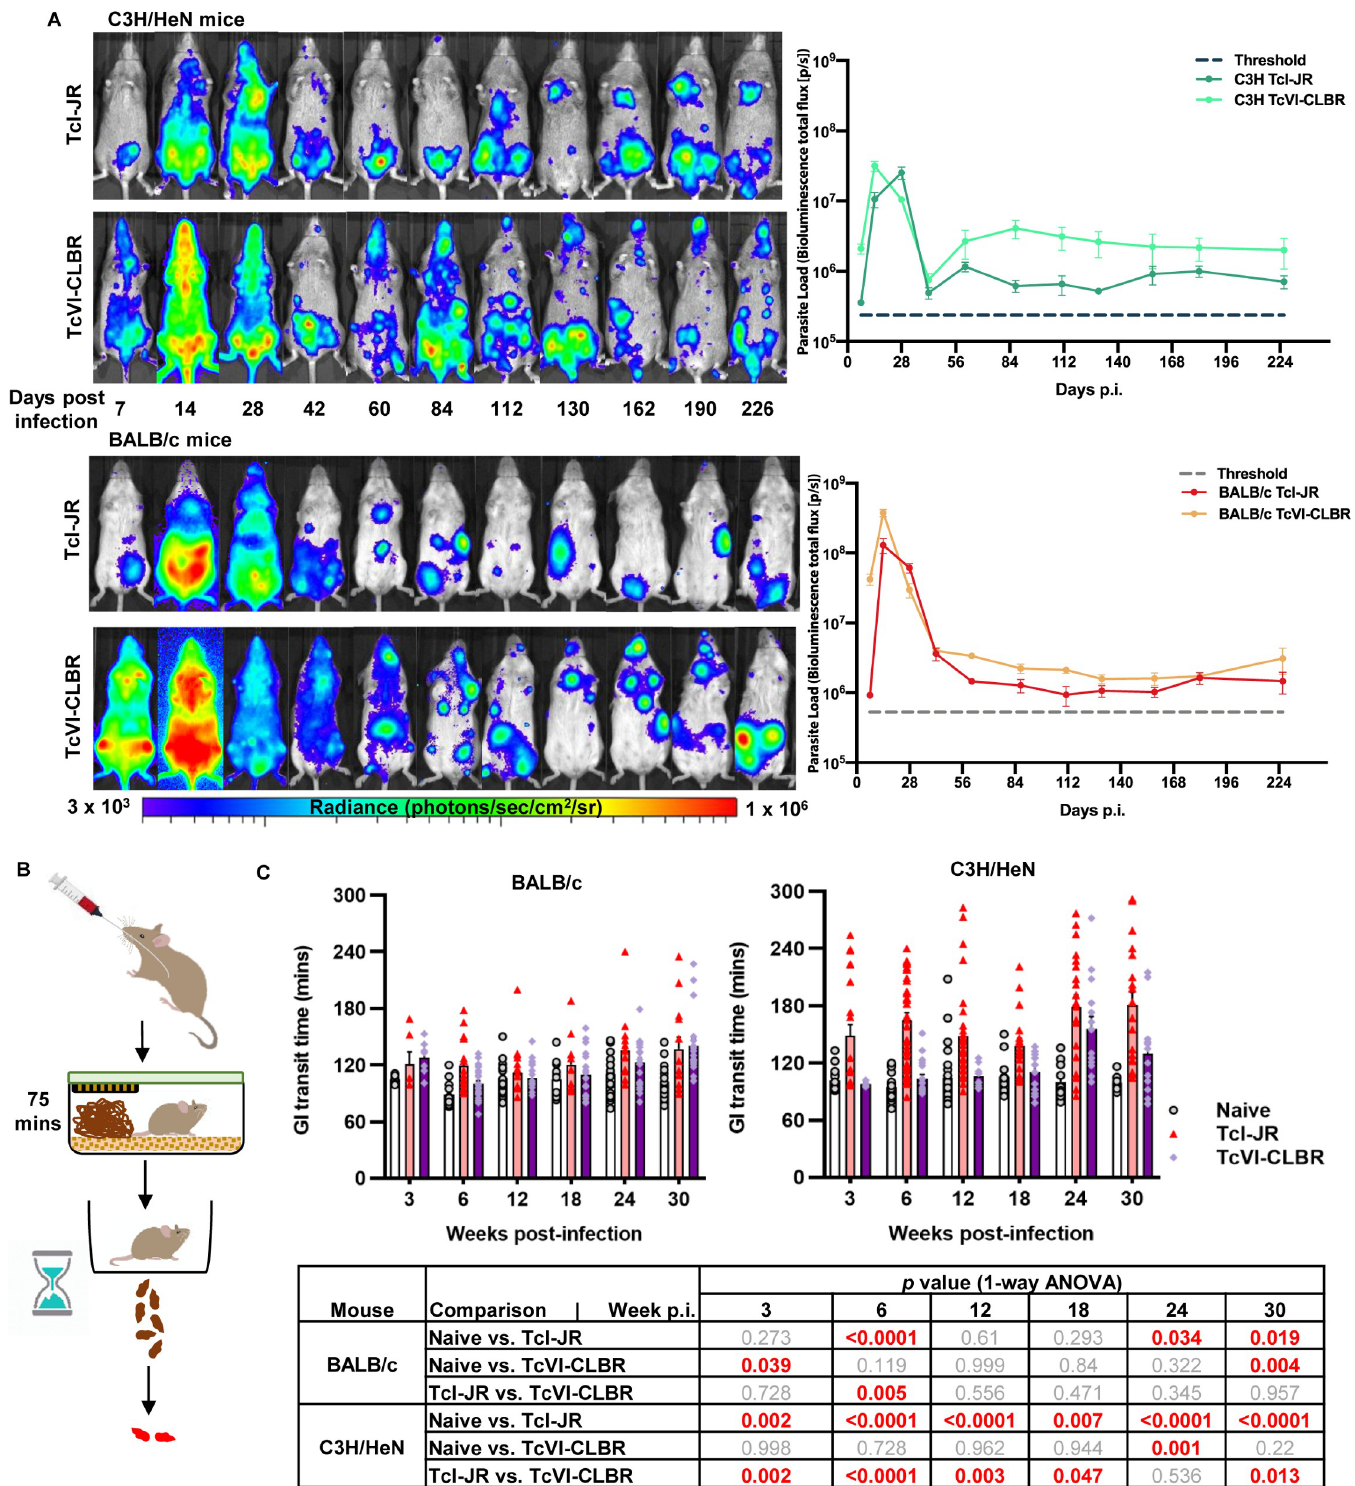
Fig 1. Bioluminescence imaging T . cruzi infection models and digestive transit dysfunction screen. A. Ventral images of female C3H/HeN (top panels) and BALB/c mice (bottom panels) representing TcI-JR (1 st and 3 rd panel) and TcVI-CLBR (2 nd and 4 th panel) course of infection. Images were captured using in vivo bioluminescence imaging. Overlaid log-scale pseudocolour heat maps are representative of bioluminescence intensity; the log-scale range is indicated in units of radiance. Adjacent line plots show parasite load represented as average bioluminescence of TcI-JR C3H/HeN ( n = 10–24), TcVI-CLBR C3H/HeN ( n = 5–12), TcI-JR BALB/c ( n = 5–12) and